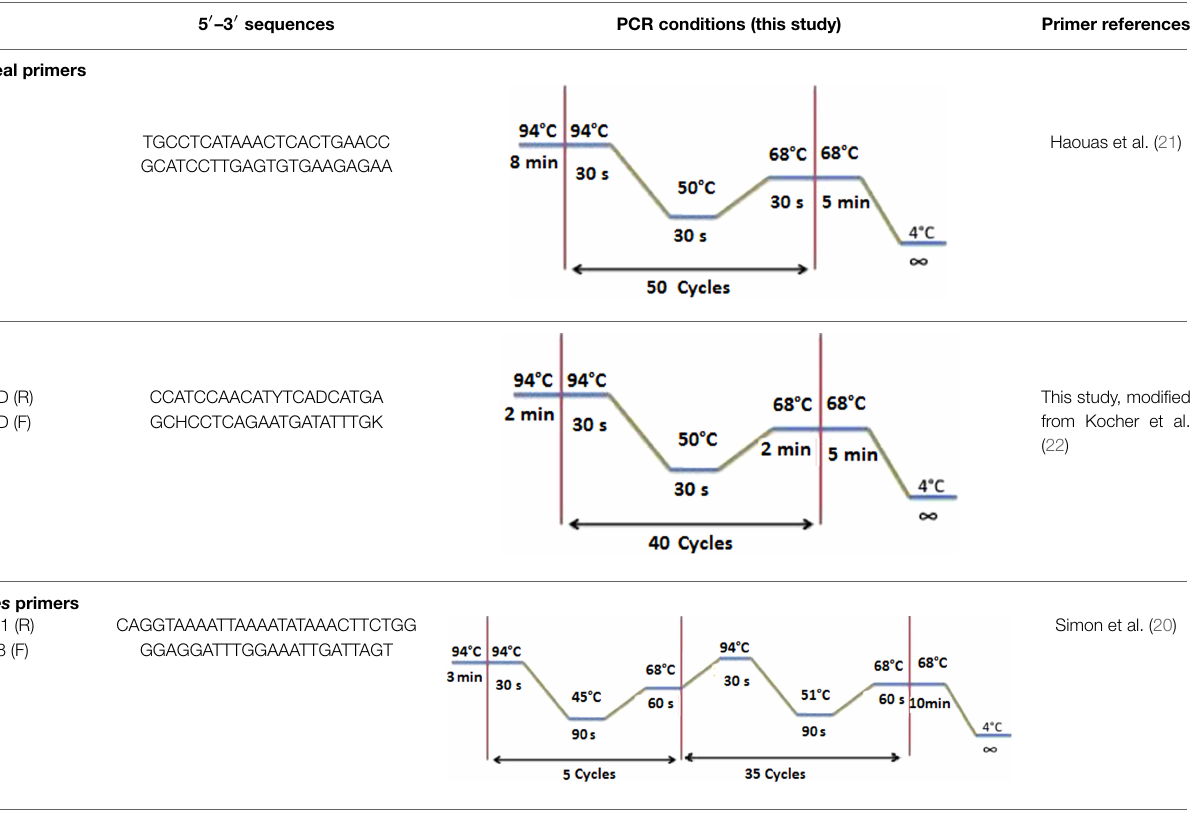
TABLE 2 | Primer sequences used in the molecular analyses of blood meals and Culicoides species identification .